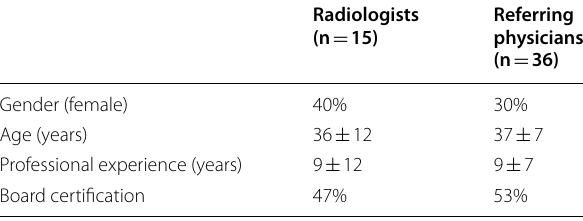
Table 2 Demographic information collected in this survey. Total numbers or mean standard ±